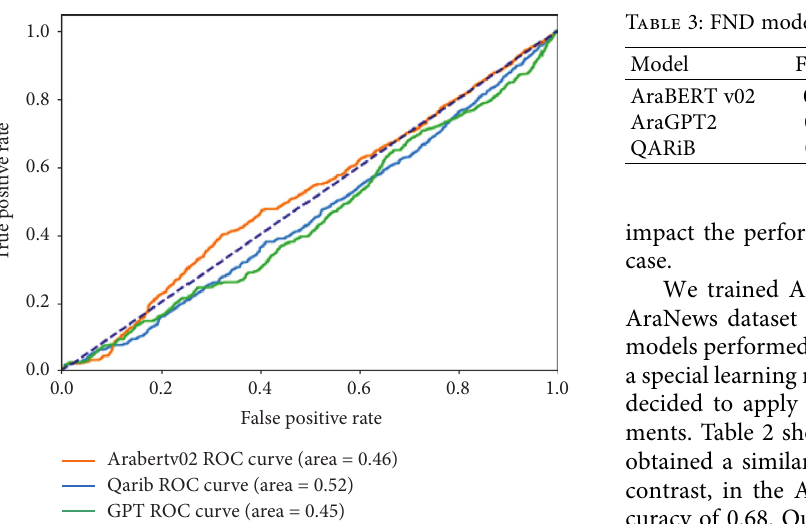
Figure 3: ROC curve for the models showing that QARiB has the best performance compared to AraBERTv02, AraGPT2.